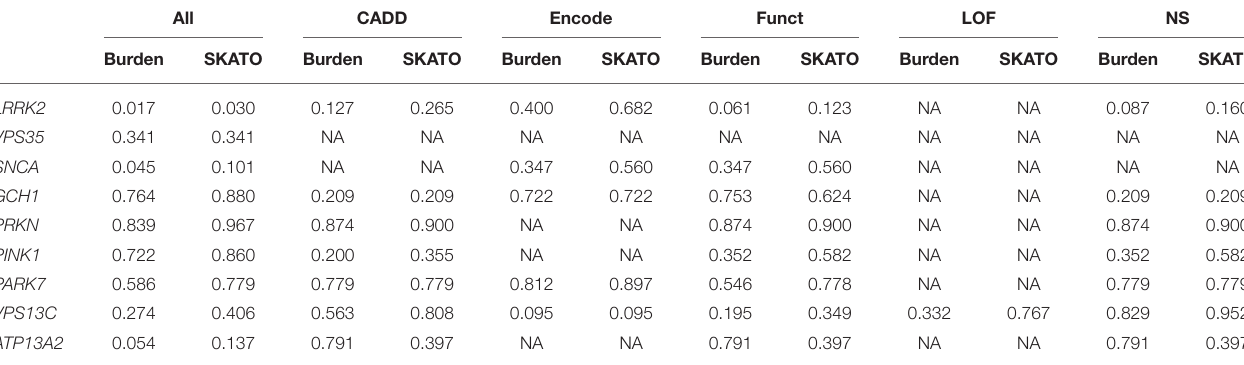
The numbers represent the uncorrected p-values of the tests. Burden, burden test; SKATO, optimized sequence Kernel association test; CADD, Combined Annotation Dependent Depletion (CADD) score of ≥ 12.37 (representing the top 2% of potentially deleterious variants); Encode, regulatory variants predicted by ENCODE; Funct, Potentially